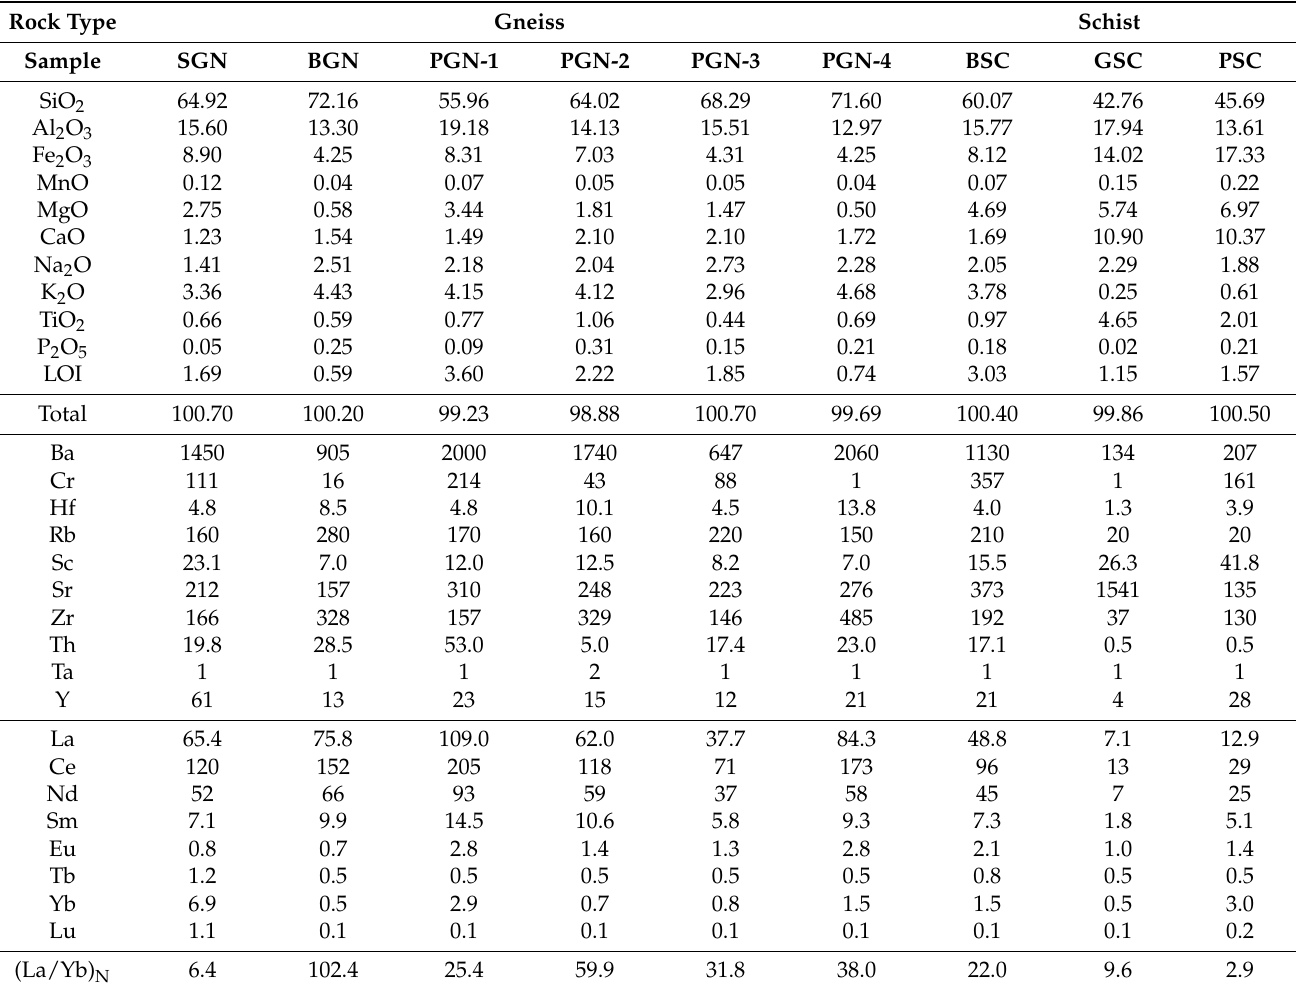
Table 3. Geochemical compositions of major oxides(wt.%) and selected minor and rare-earth ele- ments(ppm) for gneiss and schist. Sample names are as used in Table 1. LOI; loss on